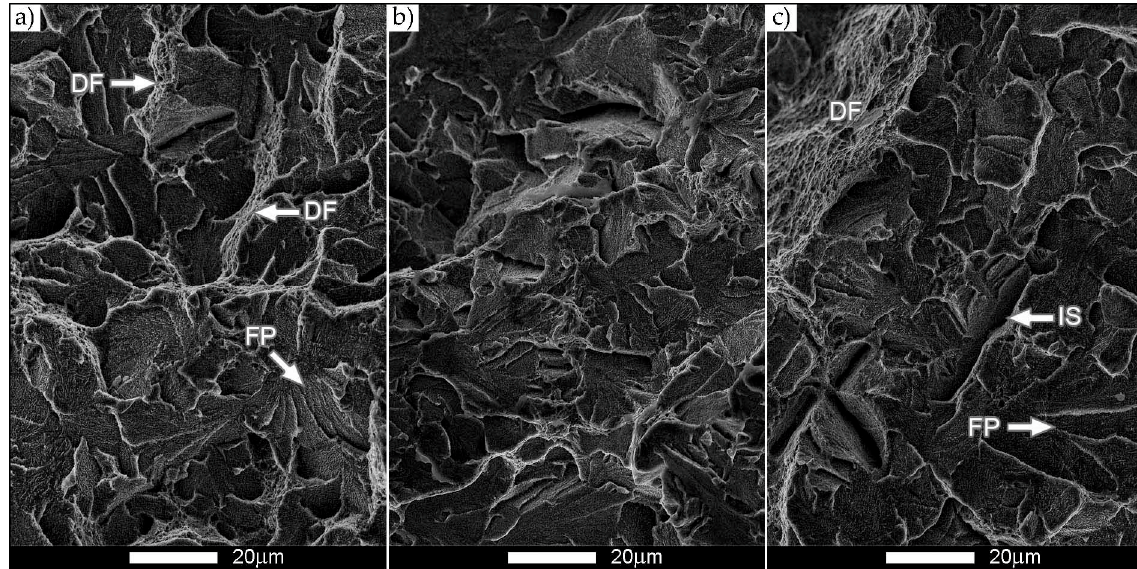
Figure 16. Images of the Hardox Extreme steel fracture surface in normalized state shown in Figure 10: longitudinal orientation ( − 40 ◦ C). ( a ) The area marked with the A1 frame. ( b ) The area marked with the B1 frame. ( c ) The area marked with the C1 frame. FP—fan pattern, T—tongues. SEM, non-etched state.